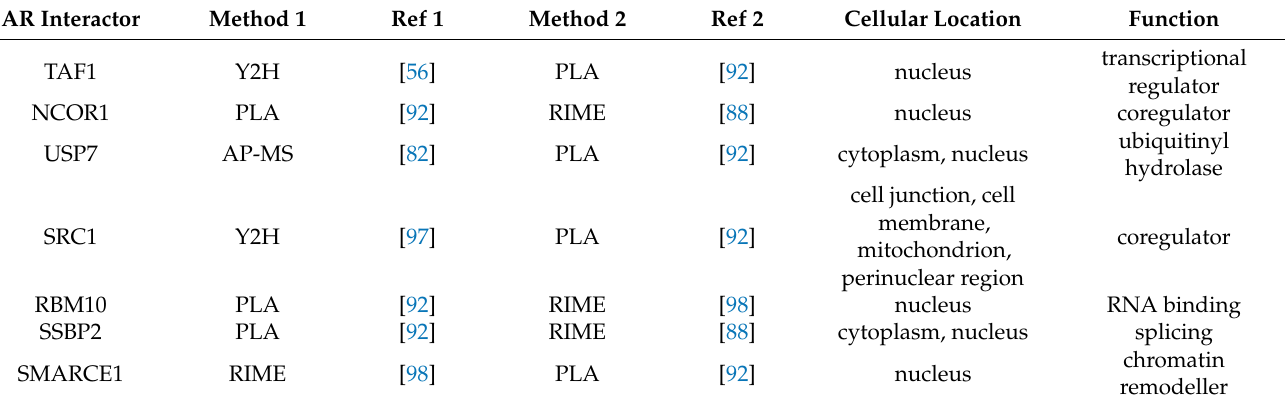
Table 2. Representative examples of AR interactors identified via 2 independent screening or char- acterization approaches. For each AR interactor, the table shows the first and the second method by which the protein was isolated, the reference for both papers reporting the interactor as associ- ated with AR, the cellular localization of the interactor and its function. Y2H, yeast 2 hybrid; PLA, proximity-ligation assay; RIME, Rapid Immunoprecipitation Mass spectrometry of Endogenous proteins; AP-MS, affinity purification mass